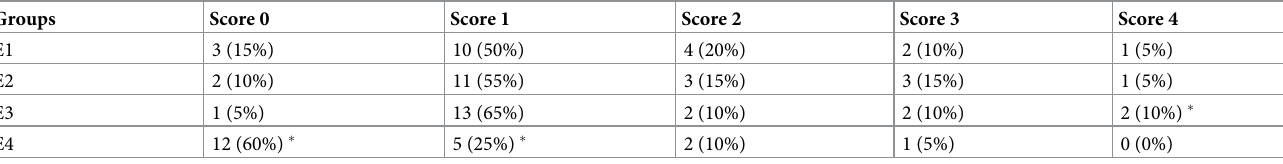
Table 2. Frequency distributions of microleakage scores on dentin/cementum